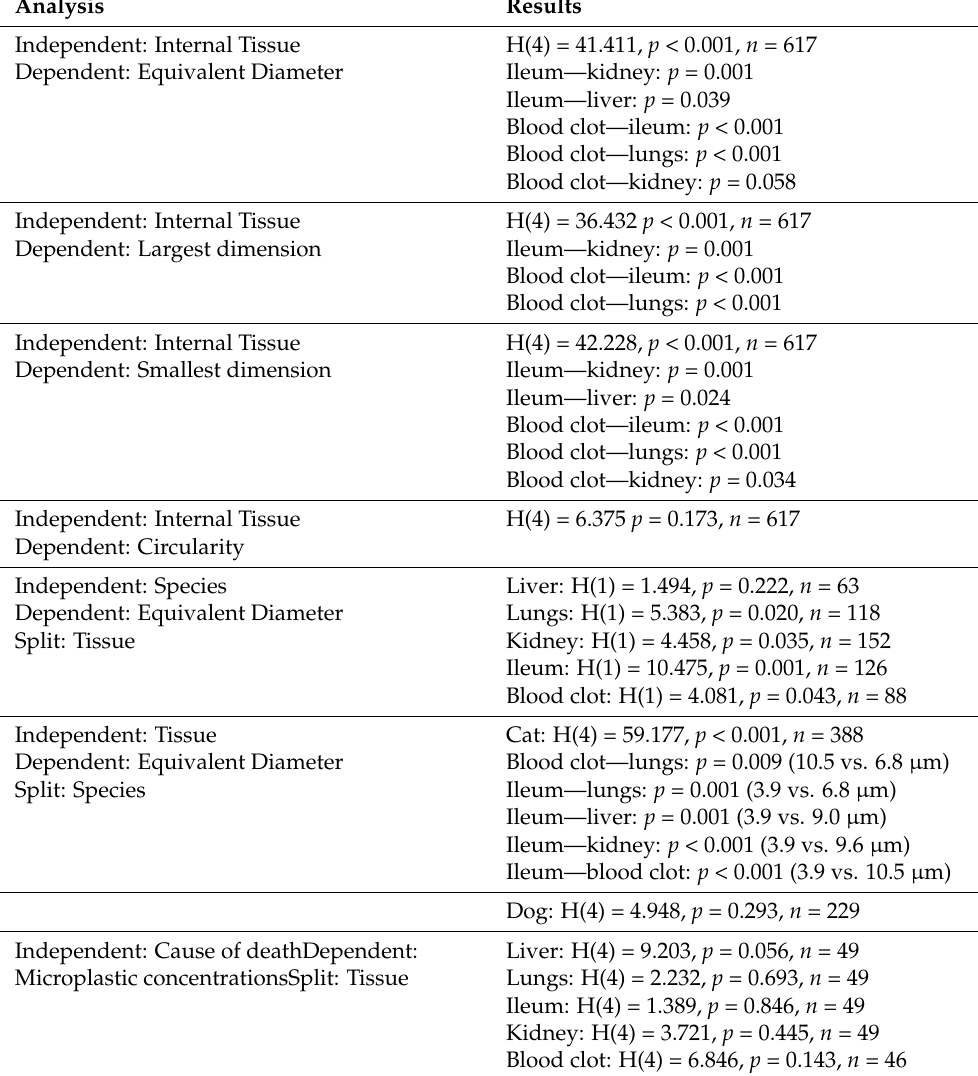
Table 1. Statistical analysis results of the non-parametric Kruskal–Wallis test followed by pairwise comparison with Bonferroni